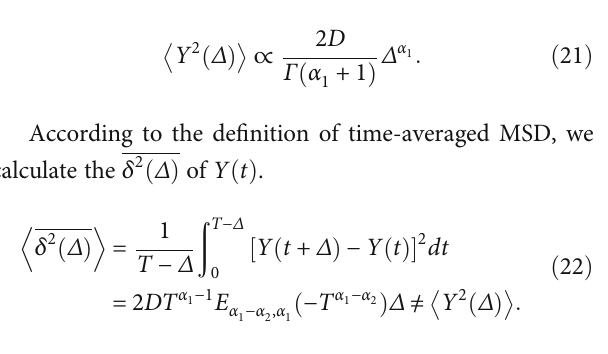
Figure 1: The sample paths of the stochastic process E α = 0 : 9 and α 1